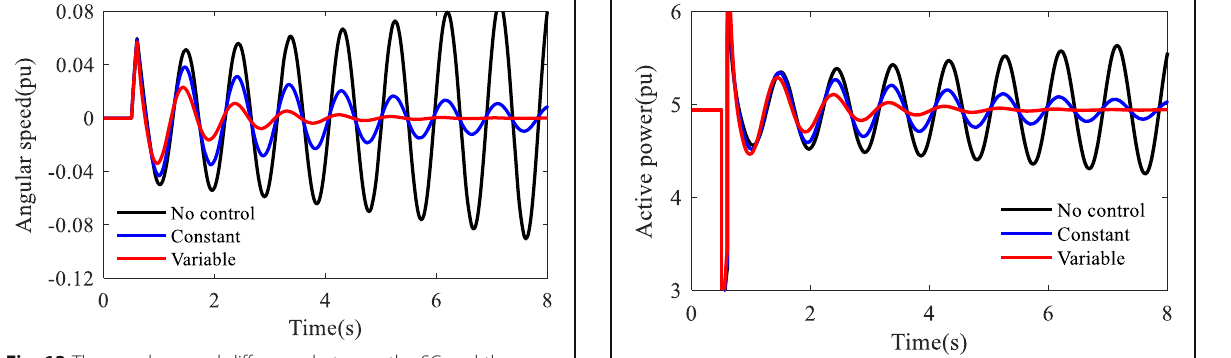
Fig. 16 The active power output of the SG when the output power of the PV is 0.09 pu